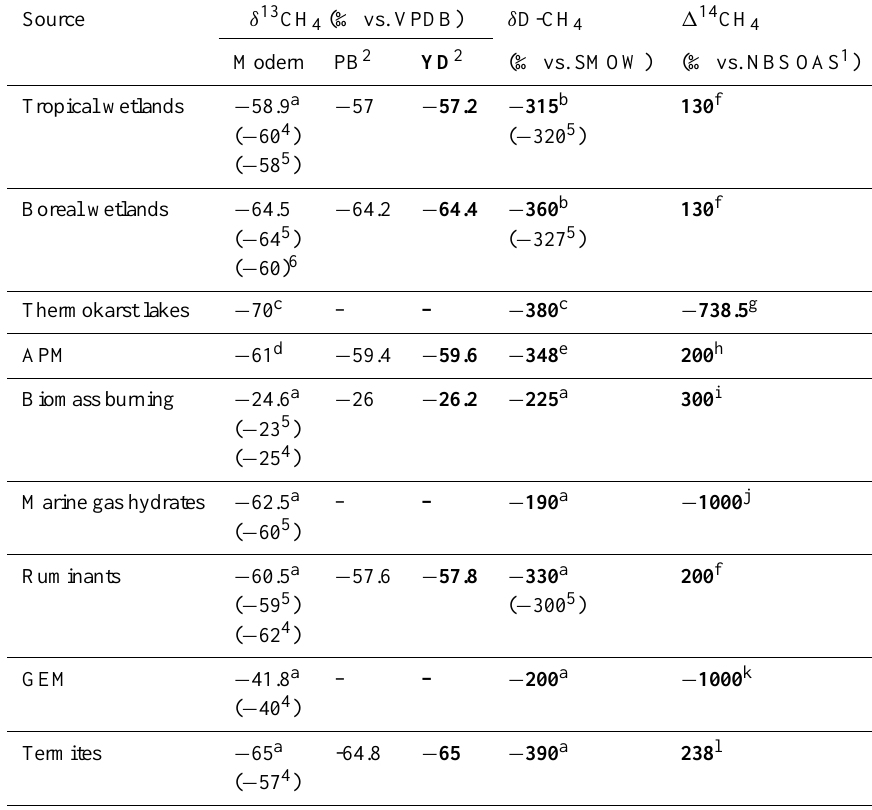
Table 2. Characteristic isotope values for primary sources used in the triple mass balance calculations. Isotope values used in the standard scenario are denoted in bold font. Isotope δ 13 CH 4 values that are assumed not to change with time are denoted by “ − ”. δ D-CH 4 and 1 14 CH 4 values are unchanged from modern isotope values. Alternative source values for the sensitivity tests are shown in